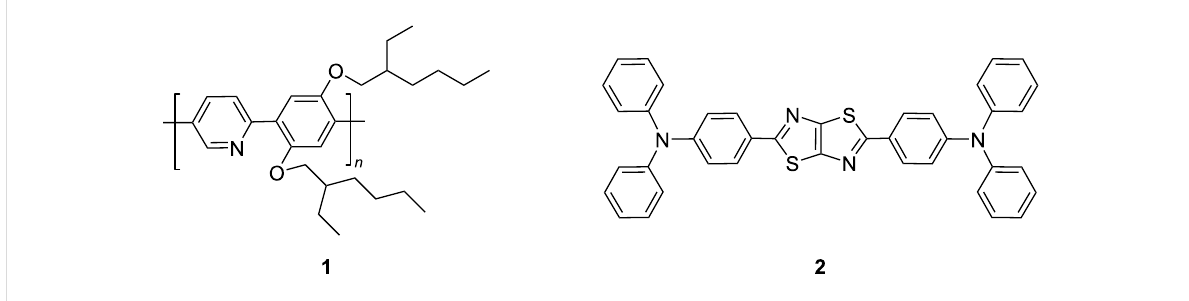
Figure 2: Chemical structures of Lewis basic fluorescent polymer poly{2,5-pyridylene- co -1,4-[2,5-bis(2-ethylhexyloxy)]phenylene} 1 and D–A–D com- pound 2,5-bis(( N , N -diphenylamino)phenyl)thiazolothiazole 2 .